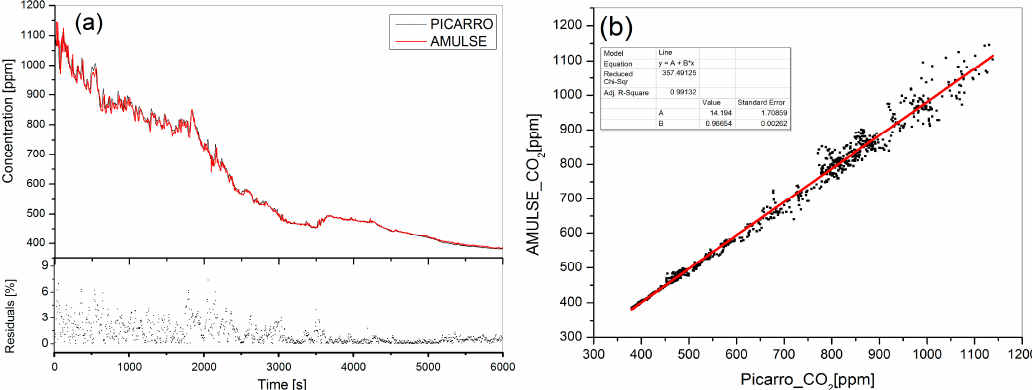
Figure 7. ( a ) Picarro vs. AMULSE intercomparison. On the upper panel Picarro’s data are plotted in black while AMULSE’s data are in red. The lower panel shows the residual uncertainties which are 7.39% at the higher concentrations and at the beginning of the intercomparison and about 0.01% at lower concentrations. The standard deviation of the uncertainty is equal to 1.2% for all the intercomparison; ( b ) The correlation between the AMULSE and Picarro’s measurements. A linear fit was applied with an adjusted R 2 of 0.99132.